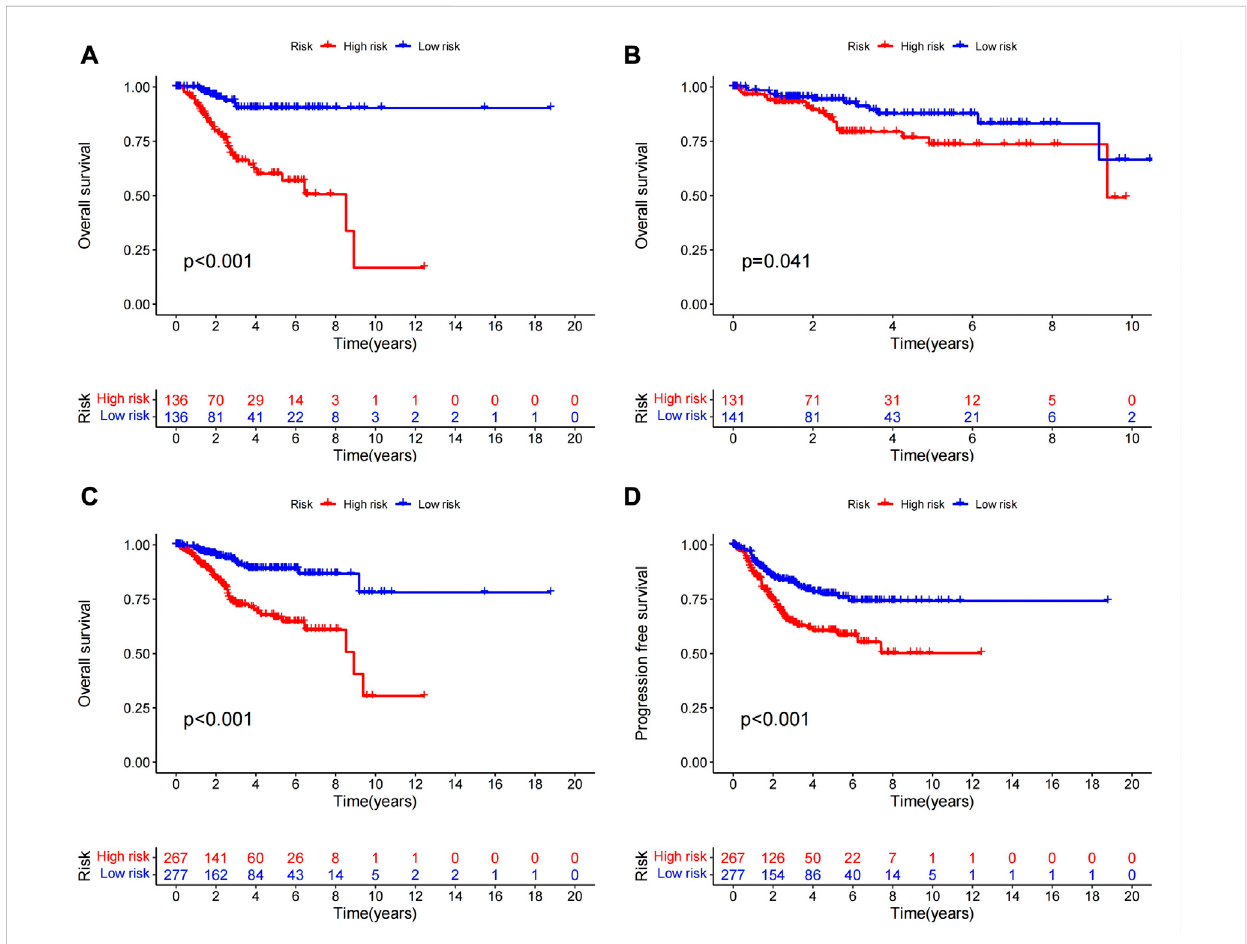
FIGURE 4 Thereweresigni fi cant differencesin survival analysis and PFS analysis betweenthehigh andlow risk groups (A) KManalysisofthetraining group. (B) KM analysis of the test group. (C) The overall KM analysis. (D) PFS.